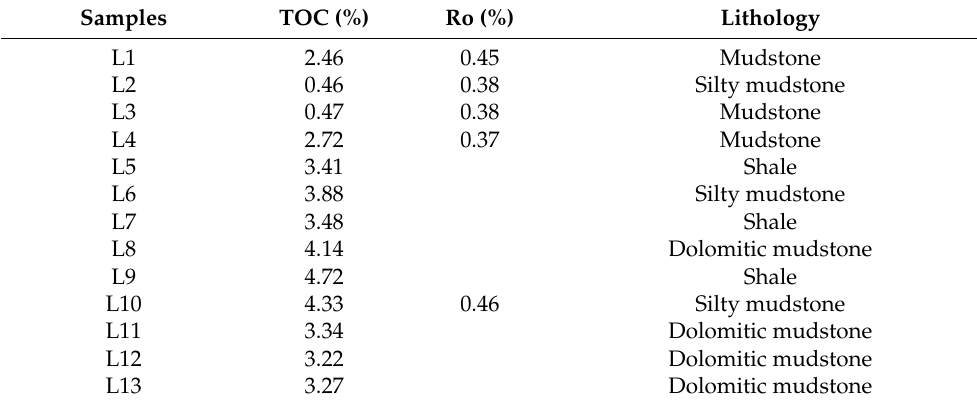
Table 1. Basic information of Sha-4 shale